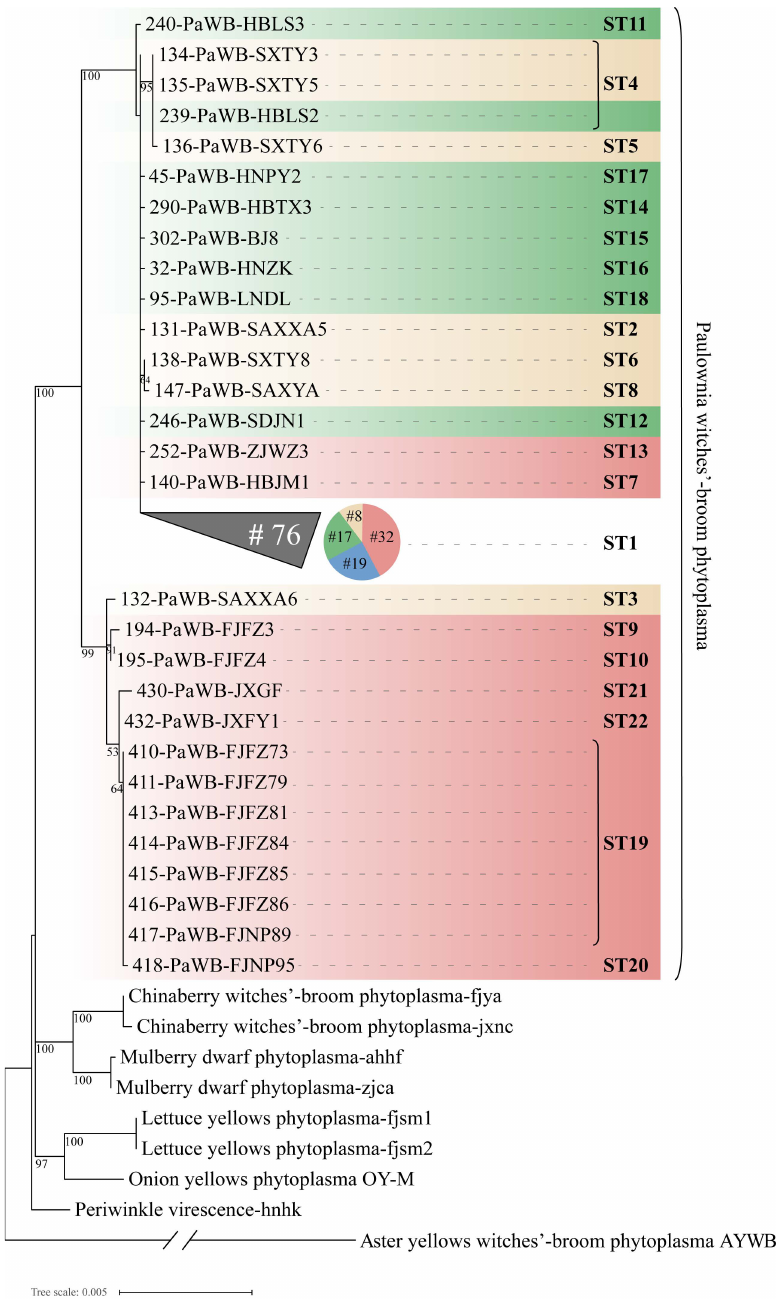
Figure 8. Phylogenetic tree constructed based on the concatenated sequences of the 105 PaWB phytoplasma strains using 7 housekeeping genes and 6 kinds of phytoplasma reference strains employing the maximum likelihood method. Four colors represent the geographical populations of PaWB phytoplasmas: Huang-huai-hai Plain population is green color gradient, northwest China population is yellow color gradient, south of the Yangtze River population is red color gradient, southwest China population is blue. The collapsed clade is displayed as a triangle, and the number (#) of strains included in the collapsed clade is indicated. The scale bar length represents inferred character-state changes under the best-fitting T92 + G model. Branch lengths are proportional to the number of inferred character-state transformations. The percentage of replicate trees in which the associated taxa clustered together in the bootstrap test (1000 replicates) is shown next to the branches. An expanded phylogeny is provided in Figure